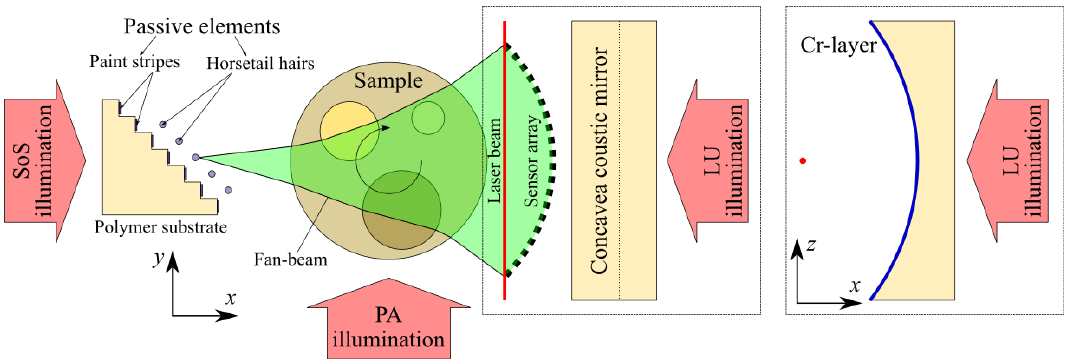
Figure 4. Combined schematic of the passive element (PE)-enriched “PA + speed-of-sound (SoS) + LU” imaging.